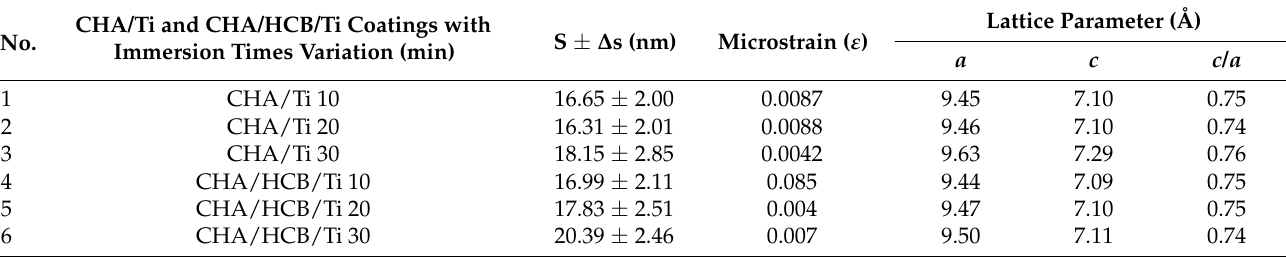
Table 5. Crystallography properties of CHA/Ti and CHA/HCB/Ti coatings.